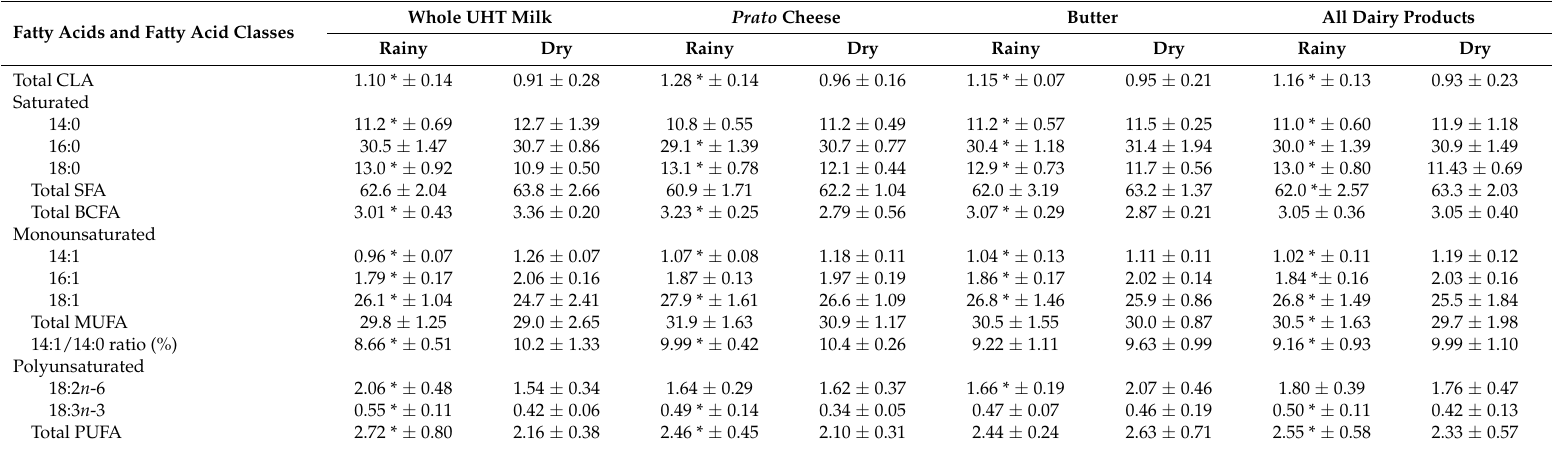
Table 2. Content of the major fatty acids and fatty acid classes in dairy products produced in southeastern Brazil during the rainy and dry seasons. Values are g/100 g total fatty acids. Whole UHT Milk Prato Cheese Butter All Dairy Products Rainy Dry Rainy Dry Rainy Dry Rainy